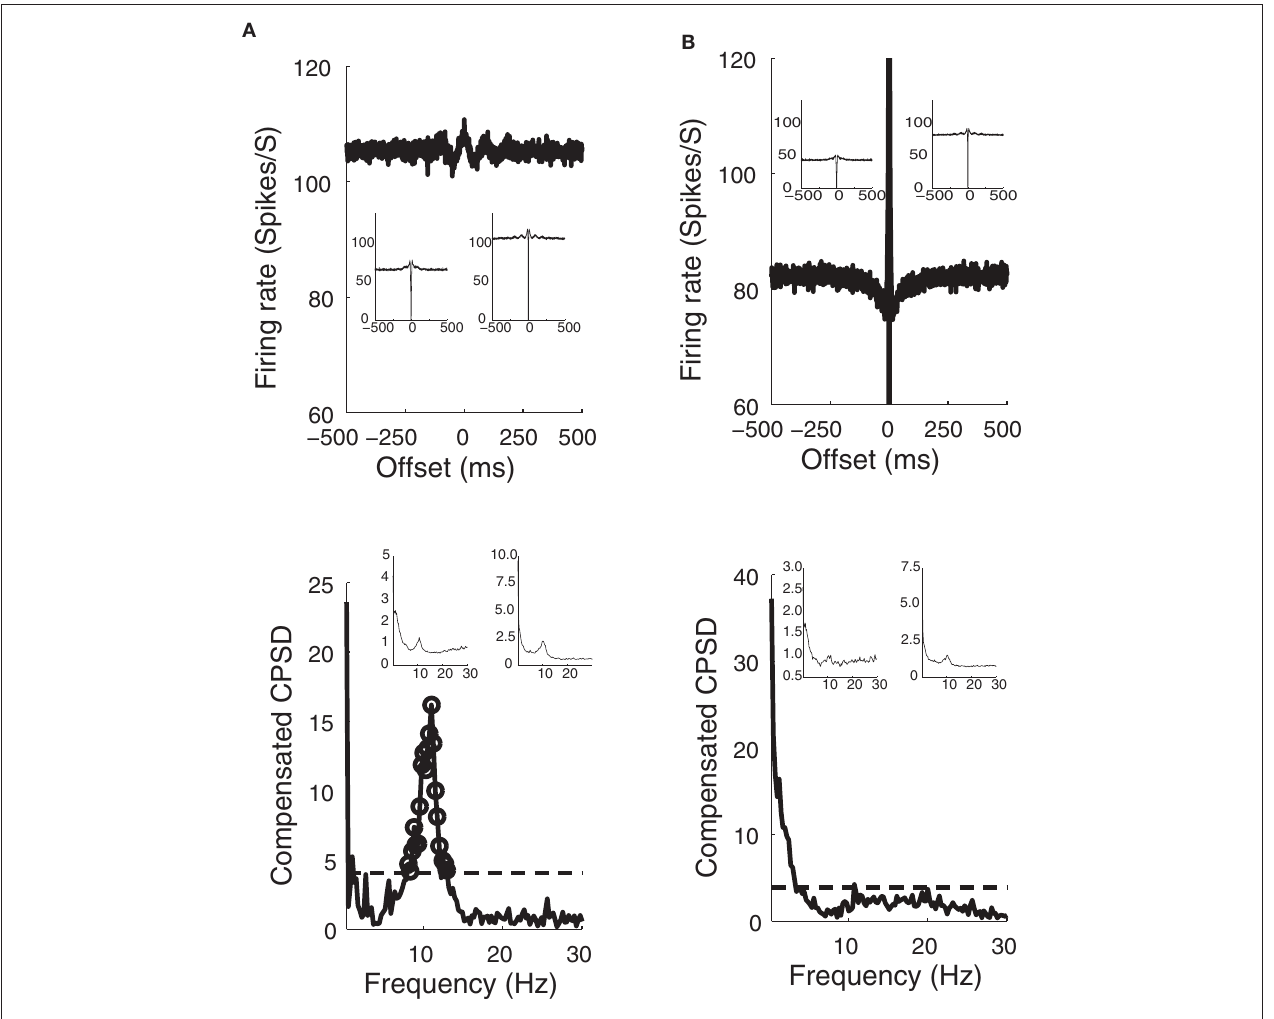
representative shadowing vectors (same one as in Figure 2 ). Similarly to Figure 2B , we can see the deflection at t = 0 (in the time domain, first row) caused by the shadowing effect. In both the time domain and the frequency domain (second row), the shadowing effect decreased the ∼ 10 Hz synchronous oscillations to an insignificant level. Conventions are the same as in Figure 2 .